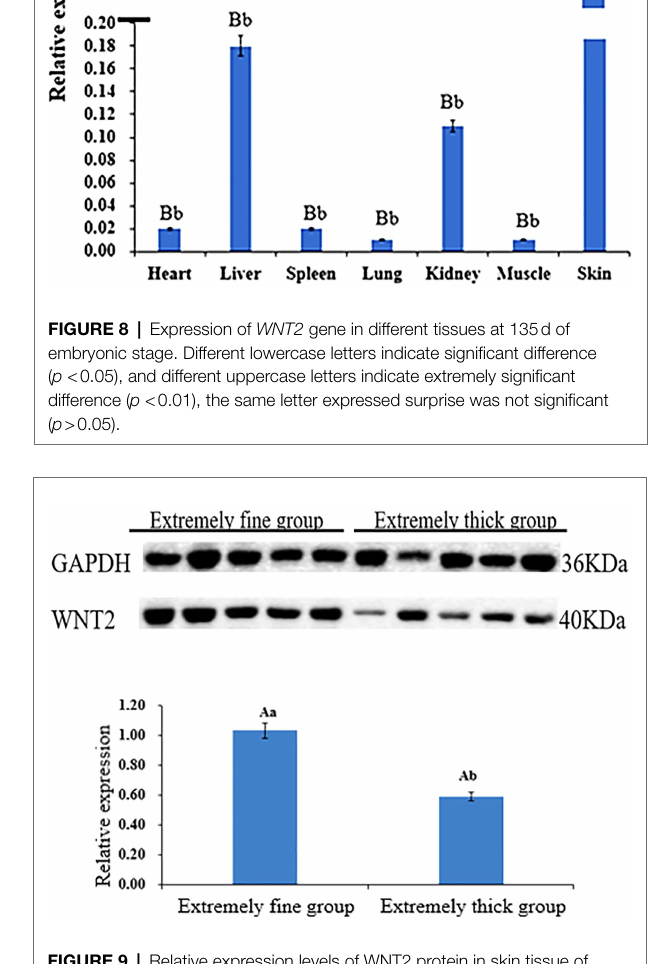
FIGURE 9 | Relative expression levels of WNT2 protein in skin tissue of Super Merino sheep with different fineness. Different capital letters indicate significant differences ( p < 0.01), and same capital letters indicate no significant differences ( p > 0.01); different lowercase letters indicate significant differences ( p < 0.05).